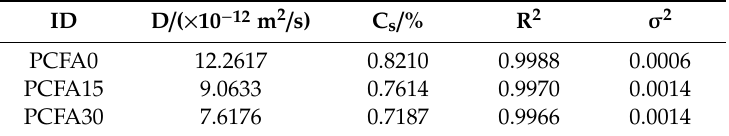
Figure 4. Regression curves of chloride coefficient using Fick’s second law (by mass%). Table 3. Regression results of chloride di ff usion coe ffi cient. D: chloride ion di ff usion coe ffi cient; C S : chloride percentage at the concrete surface; and σ 2 : the mercury surface tension